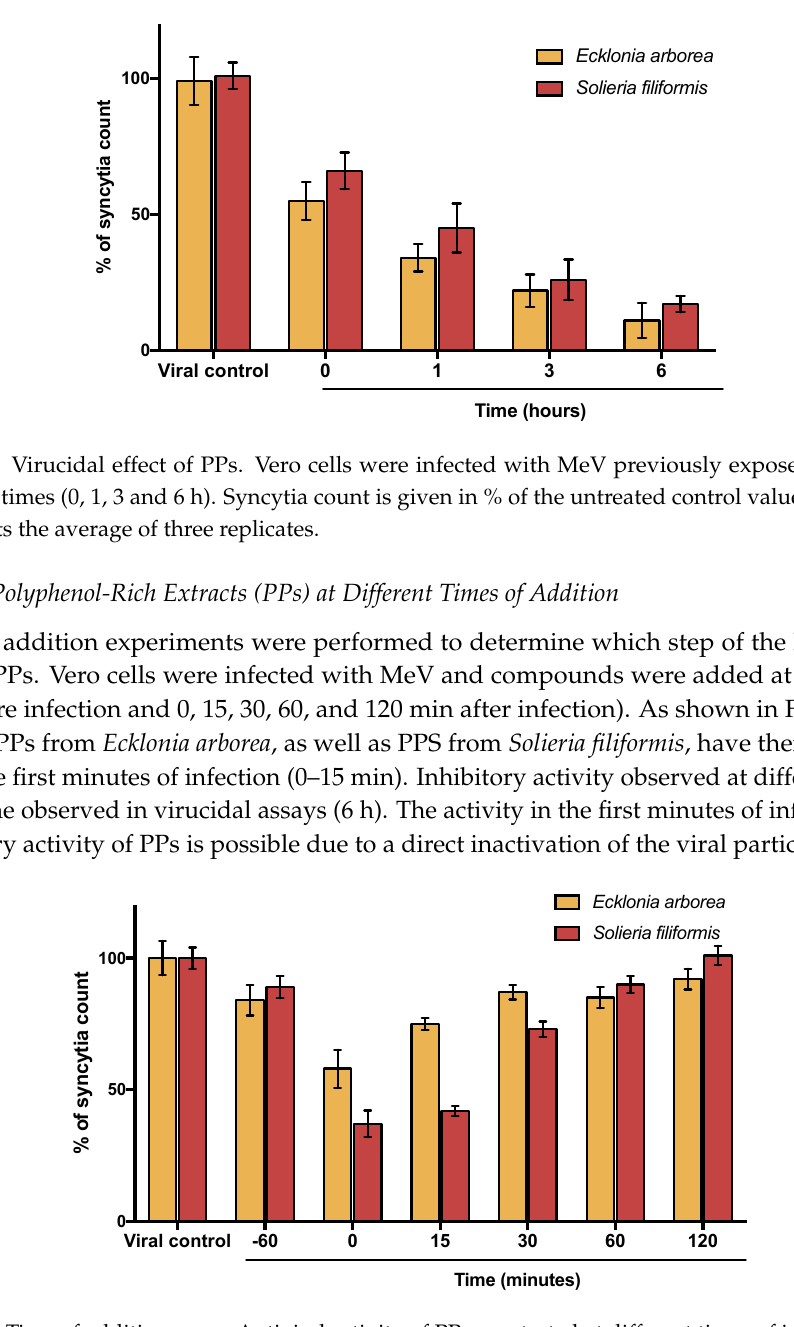
Figure 4. Time of addition assay. Antiviral activity of PPs was tested at different times of infection and analyzed by syncytia reduction assays. PPs were added to the cells 60 min before infection and at 0, 15, 30, 60, and 120 min after infection. Syncytia count is given in % of the untreated control values. Each bar represents the average of three replicates.